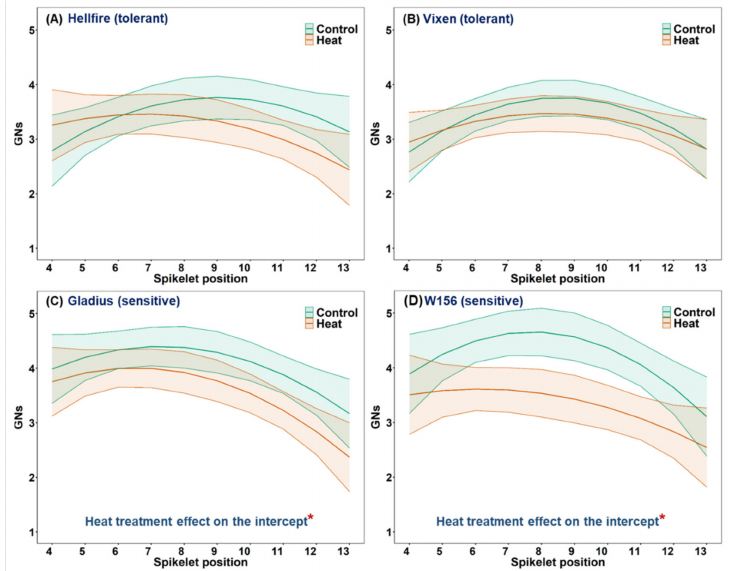
Figure 5. Impact of heat stress on grain number per spikelet (GNs) at different spikelet positions on the main stem spike in ‘tolerant’ wheat cultivars, ( A ) Hellfire and ( B ) Vixen, and ‘sensitive’ cultivars, ( C ) Gladius and ( D ) W156. The graphs show the regression lines (95% confidence interval) of the quadratic model for GNs against spikelet position (4 to 13) following control and high temperature treatments at meiosis. ‘Tolerant’ cultivars under high temperature treatment responded similarly to the control for GNs, whereas GNs were significantly reduced in ‘sensitive’ cultivars under high temperature treatment relative to control based on the significantly negative heat treatment effect on the intercept (Supplementary Table S5). ( * indicates significance at p <